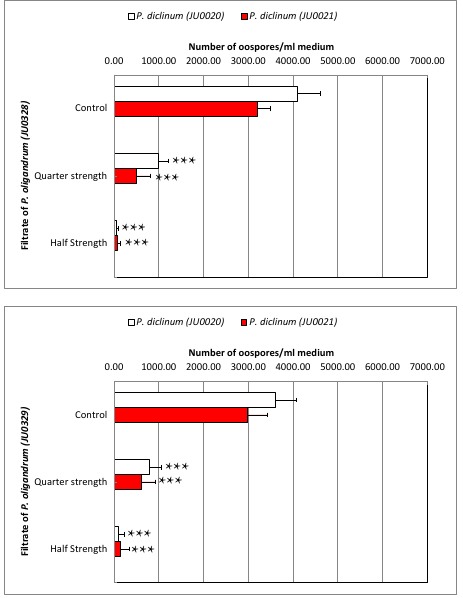
Fig. 4. Effect of cultural filtrate of two isolates of P. oligandrum on oospore production by two isolates of P. diclinum after 24 h at 20°C in the dark. Bars above all drawing column, represent the standard error of the average data from three replicates and reflect differences between averages of the samples compared to the control sample. Significant values against control represent: ** = highly significant at p < 0.01, *** = very significant at p < 0.001.